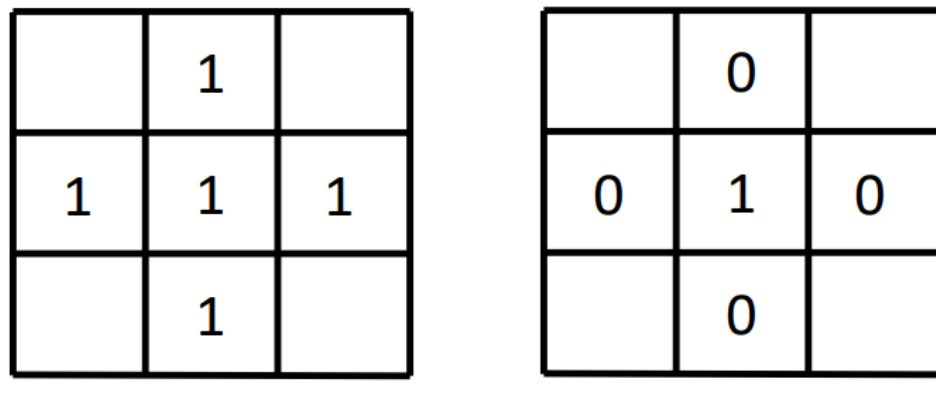
Figure 1. Internal points and isolated